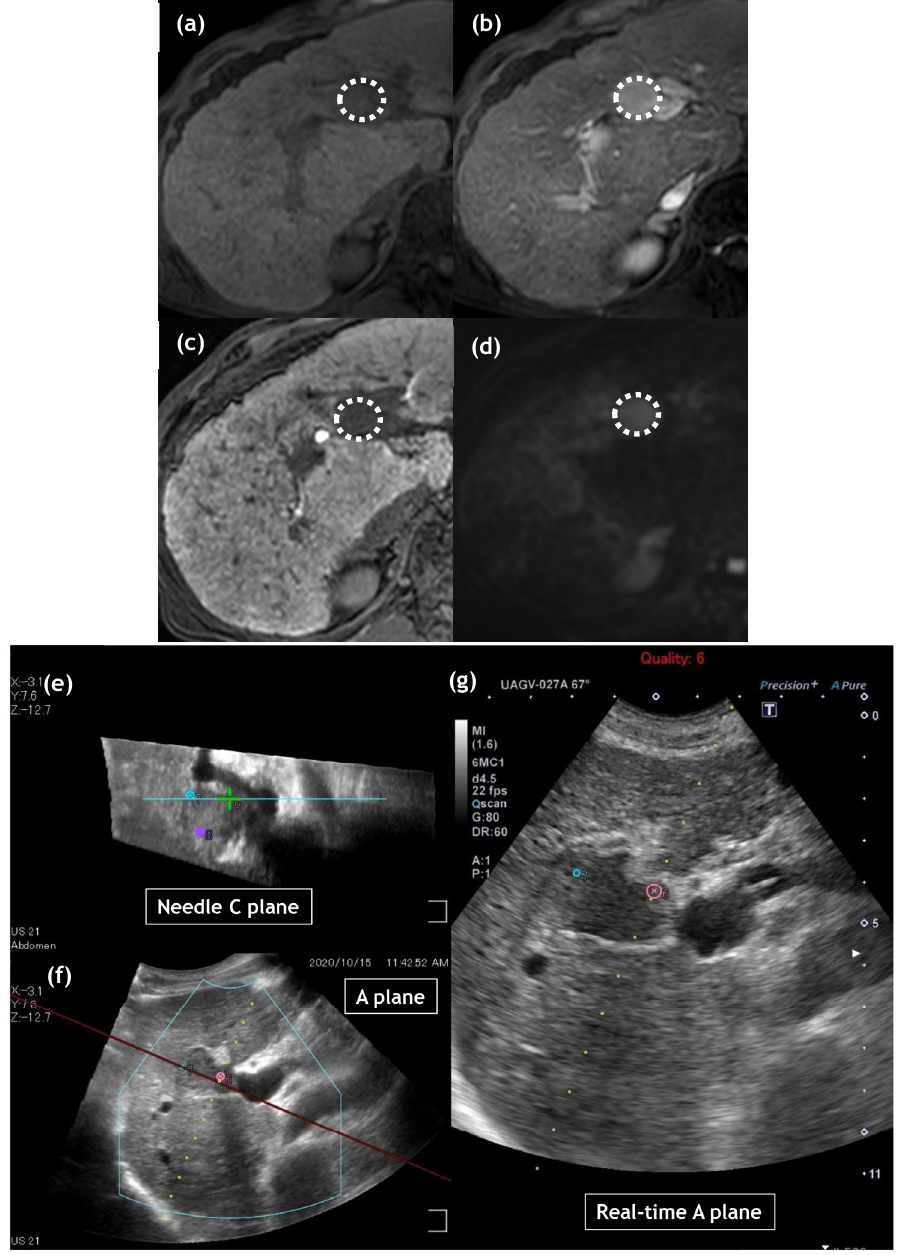
Figure 2. Images of a 70-year-old man with hepatocellular carcinoma (HCC) of 23 mm diameter in liver segment 4. On gadoxetic acid-enhanced magnetic resonance imaging, HCC shows hypointense in the pre-contrast T1-weighted image ( a : dotted circle), hyperintensity in the arterial phase ( b : dotted circle) and hypointensity in the hepatobiliary phase ( c : dotted circle). Diffusion-weighted image shows diffusion restriction ( d : dotted circle). Multiple ultrasound (US) images were reconstructed from US volume data collected using a magnetic sensor. The upper left image shows the reconstructed needle C-plane, which is perpendicular to the needle line, including the center of the tumor ( e ). The under left image shows the reconstructed A-plane, which is a normal US view ( f ). The image on the right is the real-time US image ( g ). On US-guided irreversible electroporation (IRE) planning, three spherical markers were placed on the needle C-plane (upper left: e ) , each distance of which was 18 mm. Each marker demonstrates a virtual IRE needle position, which helps us deploy IRE needles during